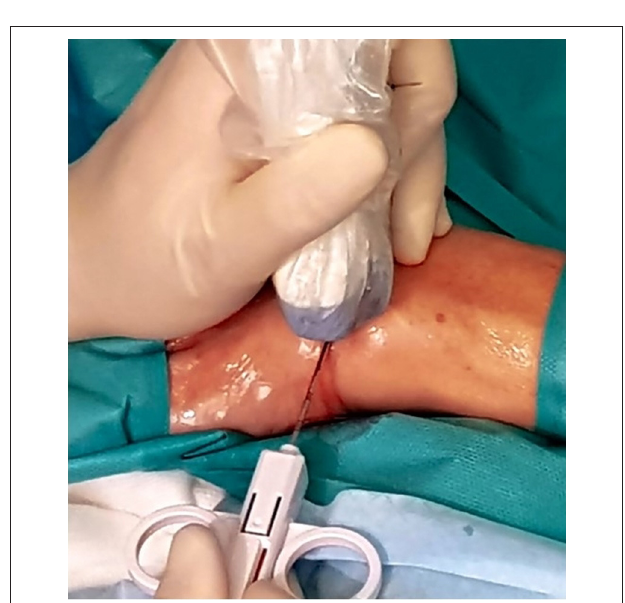
FIGURE 6 | Insertion of biopsy